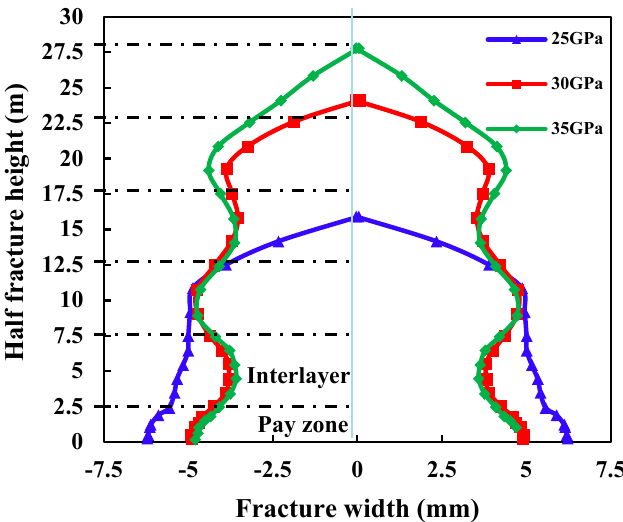
Figure 4. HF morphology under different Young’s modulus of the interlayer.